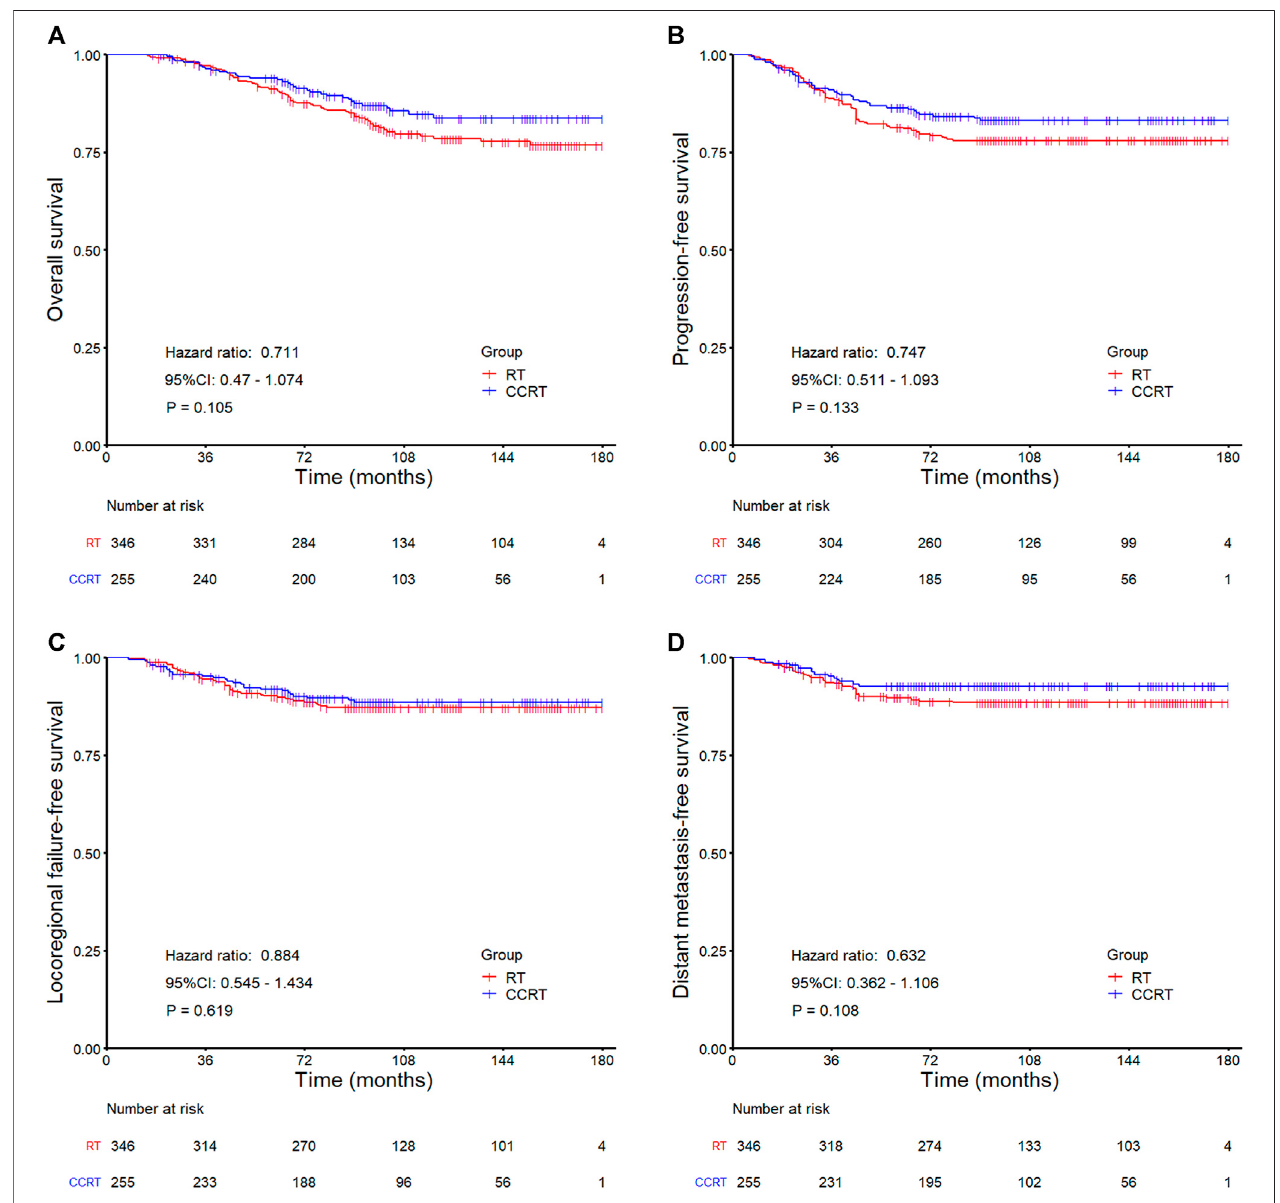
FIGURE 2 | Kaplan-Meier survival curves for the RT and CCRT groups in the whole group: (A) Overall survival, (B) Progression-free survival, (C) Locoregional failure-free survival, (D) Distant metastasis-free survival. Abbreviation: RT (cid:1) radiotherapy, CCRT (cid:1) concurrent chemoradiotherapy.